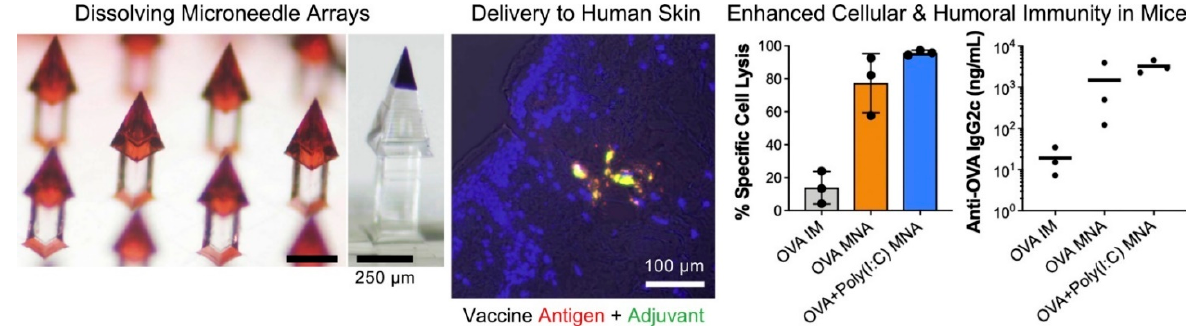
Figure 8. DMN vaccine delivery to human skin and induced immunity in mice (taken from [276]). Note: OVA—ovalbumin (model antigen), IM—intramuscular, MNA—microneedle administration.